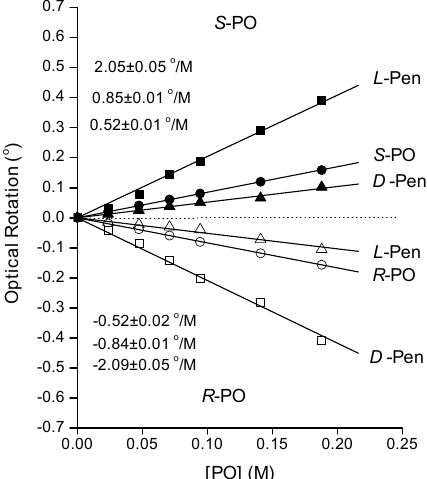
Figure 5. Optical rotation by enantiomerically pure R- and S-PO in water and in aqueous solutions of enantiomerically pure L- or D -Pen. In aqueous solution (● and ○ ), pure R- and S-PO rotate light with a specific rotation of ± 0.85 ± 0.01 °/M. In the presence of enantiomerically pure L- or D-Pen, the optical rotation of S-PO changes to 2.1 and 0.5 °/M, respectively. The optical rotations of R-PO are related to those of S-PO by diastereomerism. The concentration of D- and L-Pen was 0.025 M.